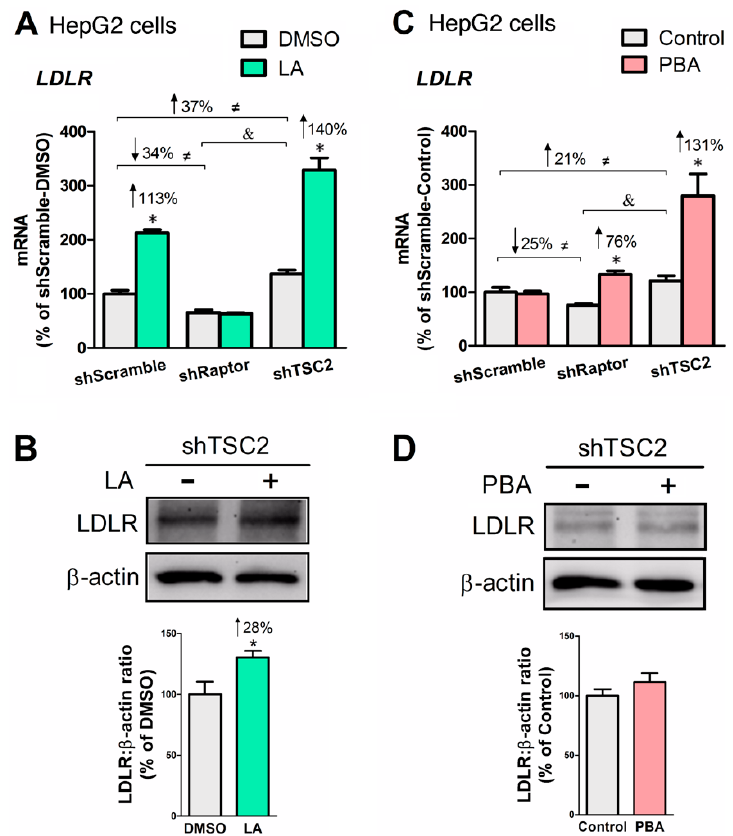
Figure 6. LA upregulated LDL receptor (LDLR) expression at both mRNA and protein levels, whereas PBA only increased LDLR mRNA. ( A ) LDLR mRNA levels as affected by LA in mTORC1-manipulated HepG2 cells. ( B ) LDLR protein abundance in HepG2-shTSC2 treated +/– LA. ( C ) LDLR mRNA level as affected by PBA in mTORC1-manipulated HepG2 cells. ( D ) LDLR protein abundance in HepG2-shTSC2 treated +/– PBA. * indicates a statistically significant effect of LA or PBA vs. vehicle control within a given cell line; & indicates a statistically significant effect of shRaptor vs. shTSC2 vehicle control; ≠ indicates a statistically significant effect of mTORC1 between stable cell lines; Student’s t -test, p < 0.05, n = 4.